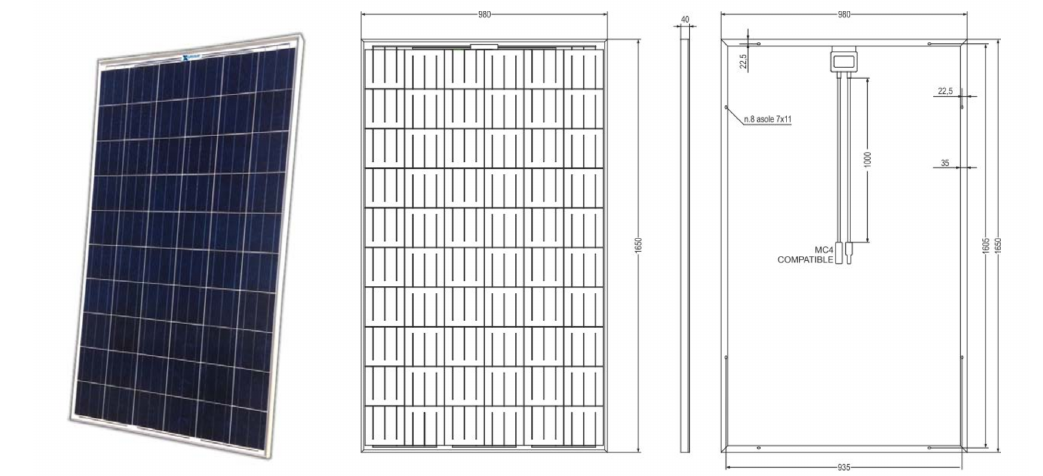
Figure 2. PV module dimensions in